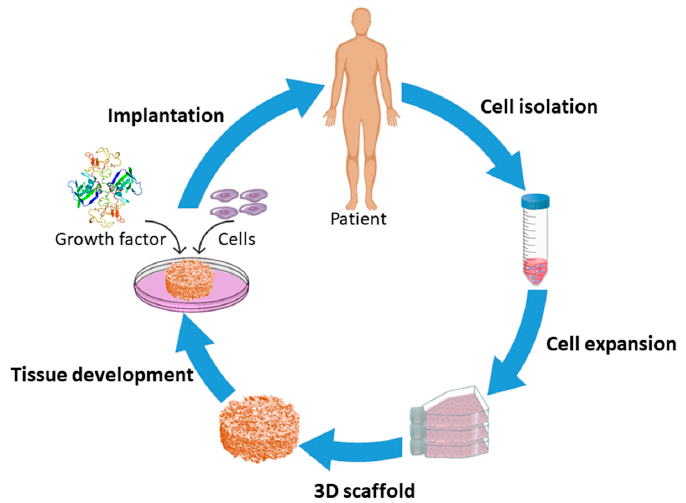
Figure 1. Schematic of the scaffold-based tissue engineering approach.